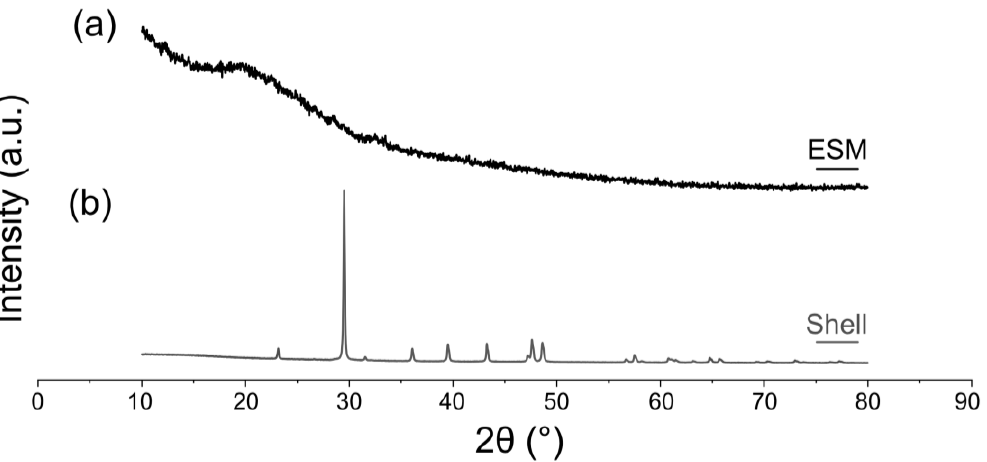
Figure 7. XRD patterns of the eggshell and ESM (mechanically removed from the shell). ( a ) ESM. ( b ) Mineral shell membrane without organic membrane. The membrane was removed manually.